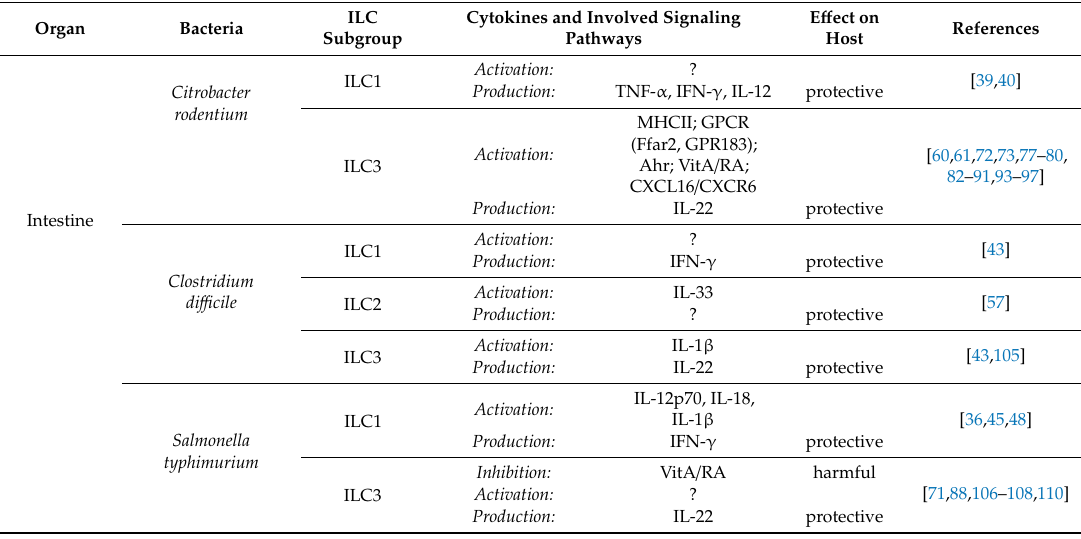
Table 1. Participation of innate lymphoid cell (ILC) subgroups in bacterial infection